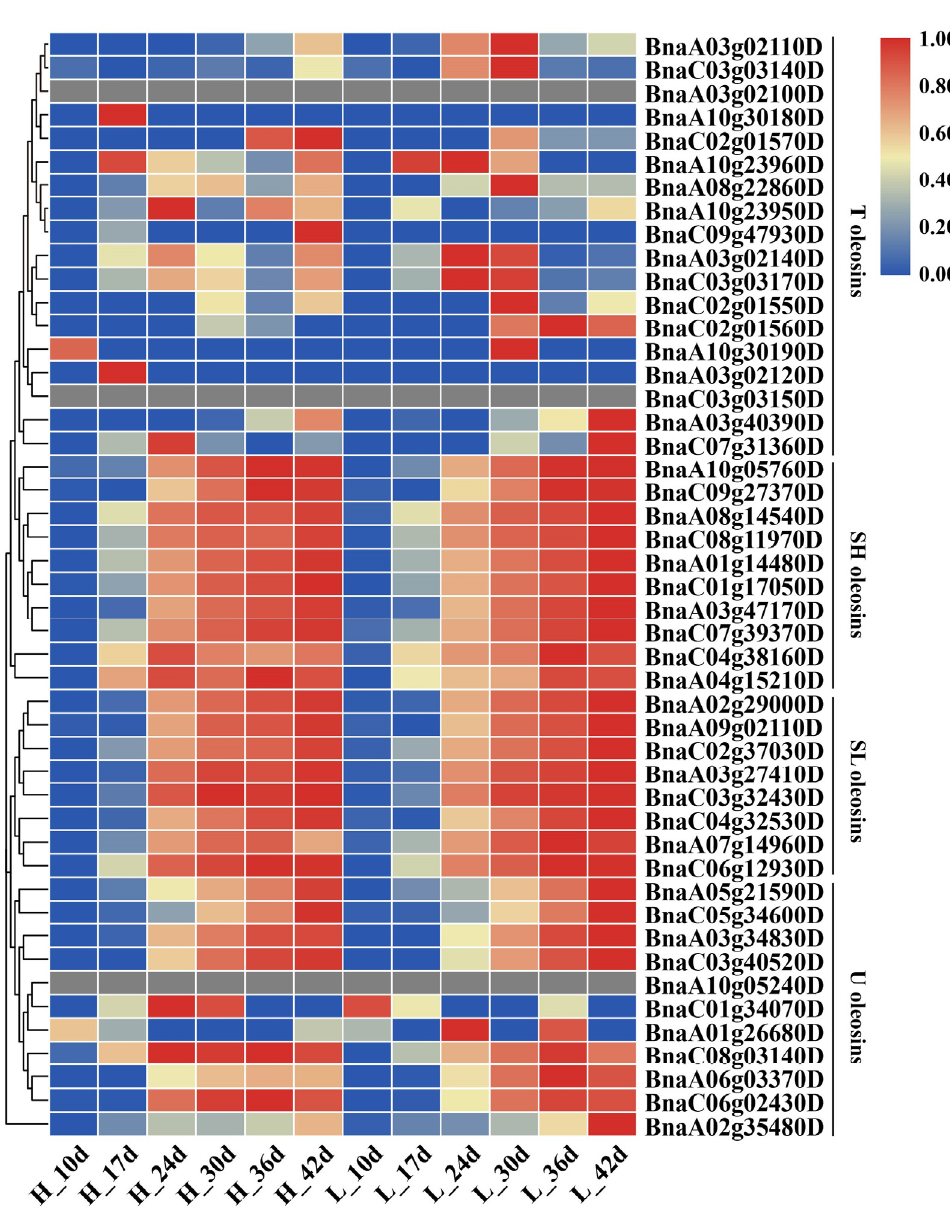
Figure 5. Heatmap of the oleosin gene family in HOC and LOC materials. The colors correspond to the value of FPKM, ranging from blue (low expression) to red (high expression).